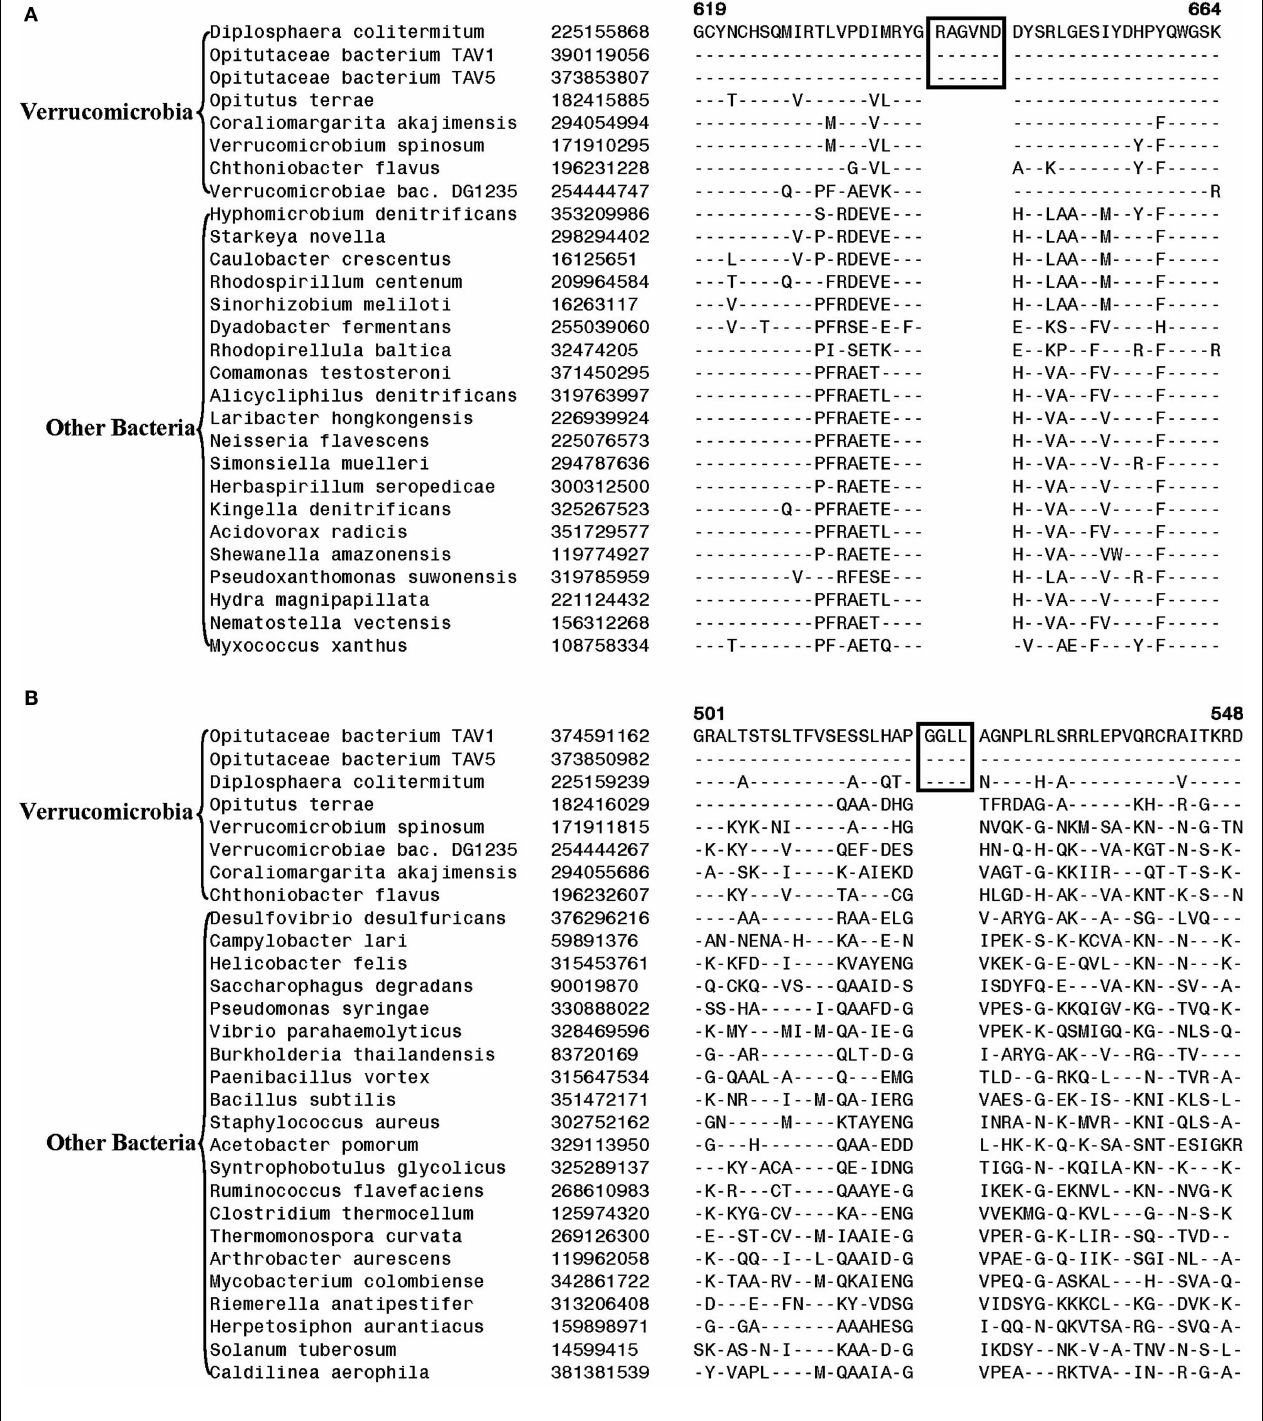
FIGURE 3 | Partial sequence alignment of (A) Cytochrome c oxidase and (B) alpha subunit of urease, showing two CSIs (boxed) that are specifically present in D. colitermitum , Opitutaceae bacteriumTAV1 , and Opitutaceae bacteriumTAV5 species.